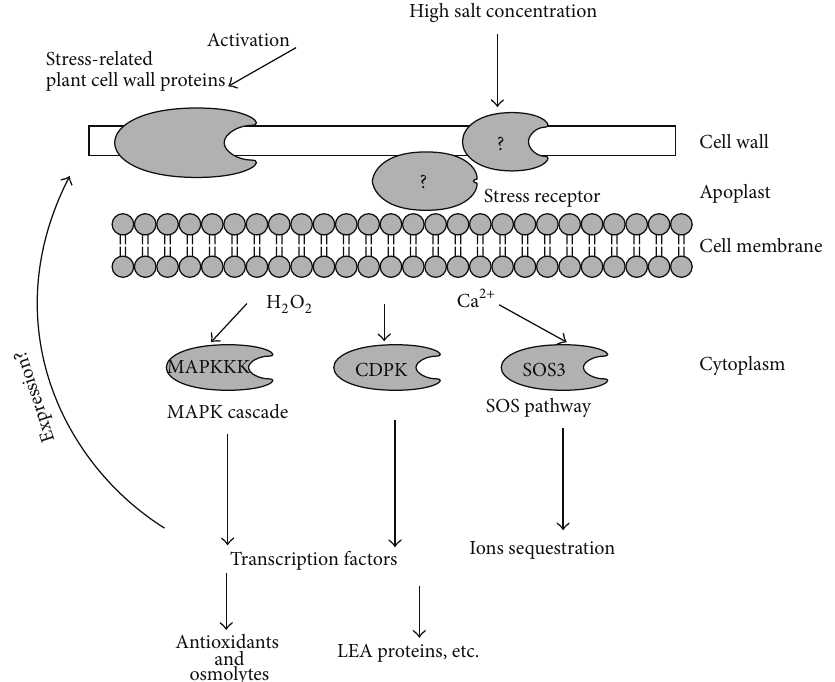
Figure 2: Perception and signaling during salt stress response. The major pathways inside the cell (MAPK, CDPK, and SOS) are well known. Most of them are Ca 2+ -dependent, but oxidative signaling involving H 2 O 2 is also an important mechanism that is currently better understood. Still the data on possible involvement of cell wall receptors like cell wall associated kinases are scarce and need to be